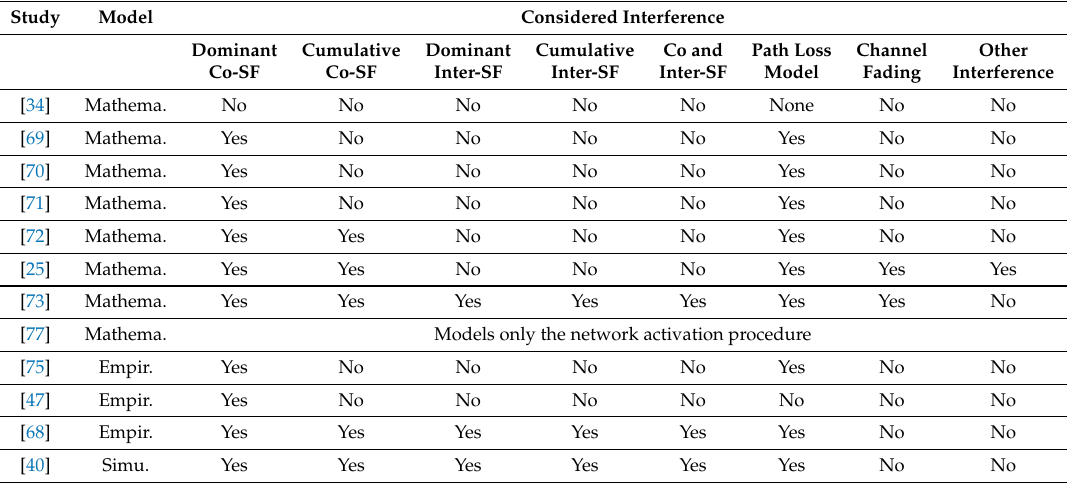
Table 5. Proposed system models for